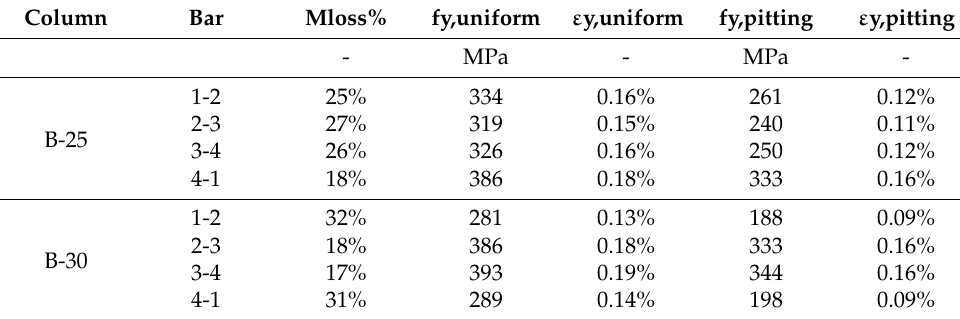
Table 4. Mechanical parameter reduction for modelling strategies 1 and